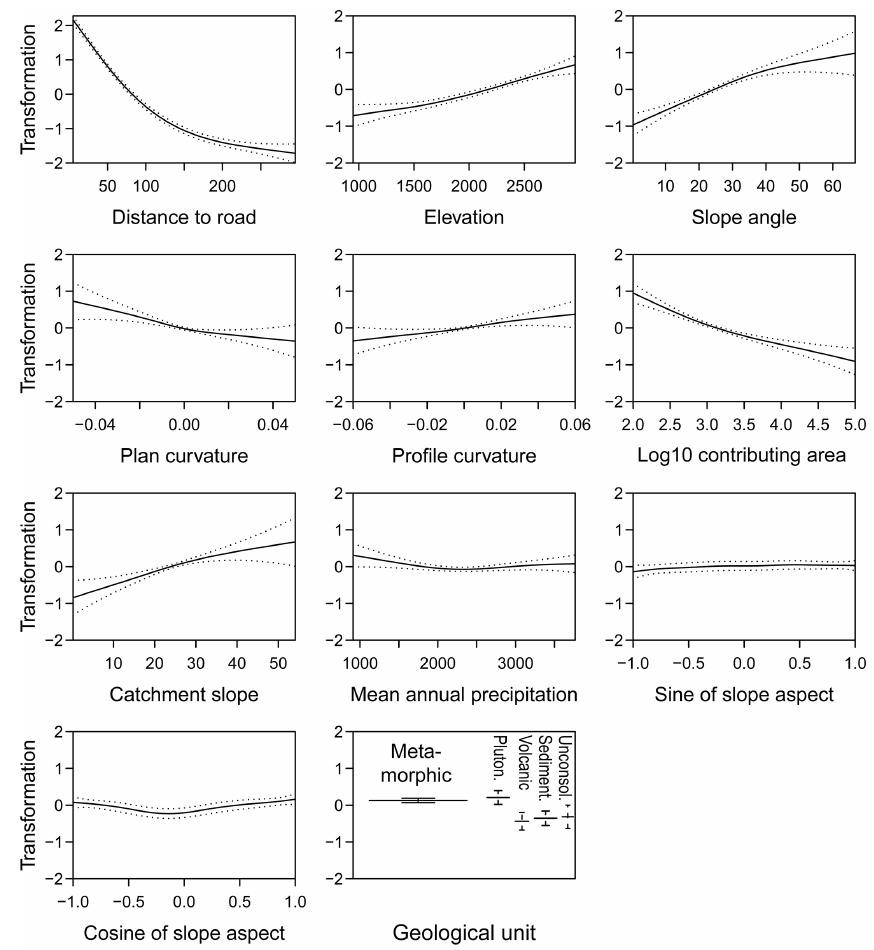
Figure 3. Transformation functions of the generalized additive model (GAM) without interaction